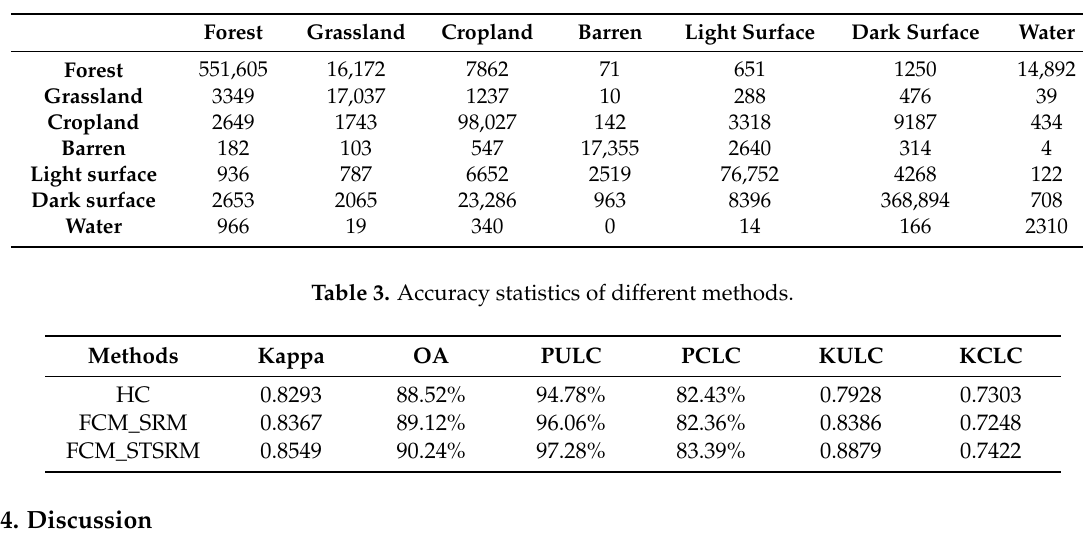
Table 2. Confusion matrix for the proposed FCM_STSRM in the entire area.